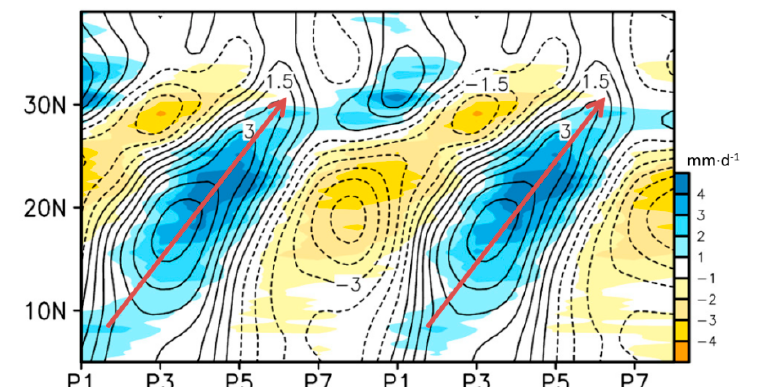
Figure 7. Latitude-phase diagram (averaged between 115 ◦ E–125 ◦ E) based on the daily anomalies of rainfall intensity (shaded areas; unit: mm d − 1 ) and daily anomalies of vertical integrated specific humidity (contours; unit: kg m − 2 ) for the composite at each phase of BSISO2, during May and June 2014 to 2017. The red arrow is added to help indicate the northward propagation feature.